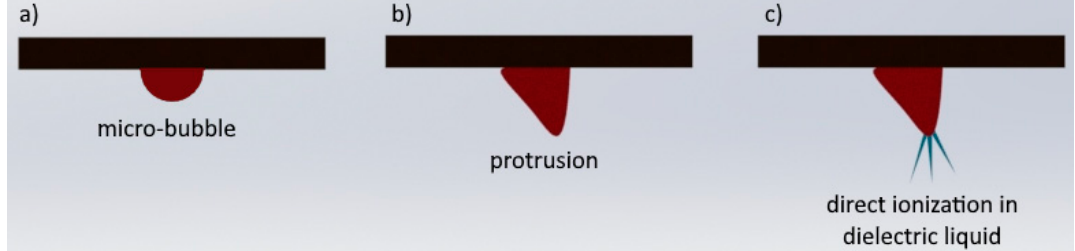
Figure 1. Formation of the streamer near the electrode. ( a ) Bubble cluster; ( b ) protrusion; ( c ) gas channels.